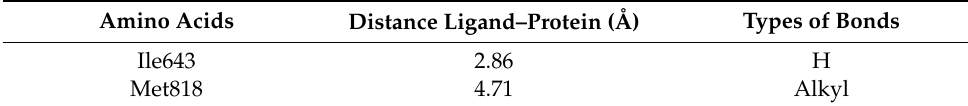
Table 4. Memantine–AChE ligand–receptor interactions at the chain. Table 4. Memantine – AChE ligand – receptor interactions at the chain.